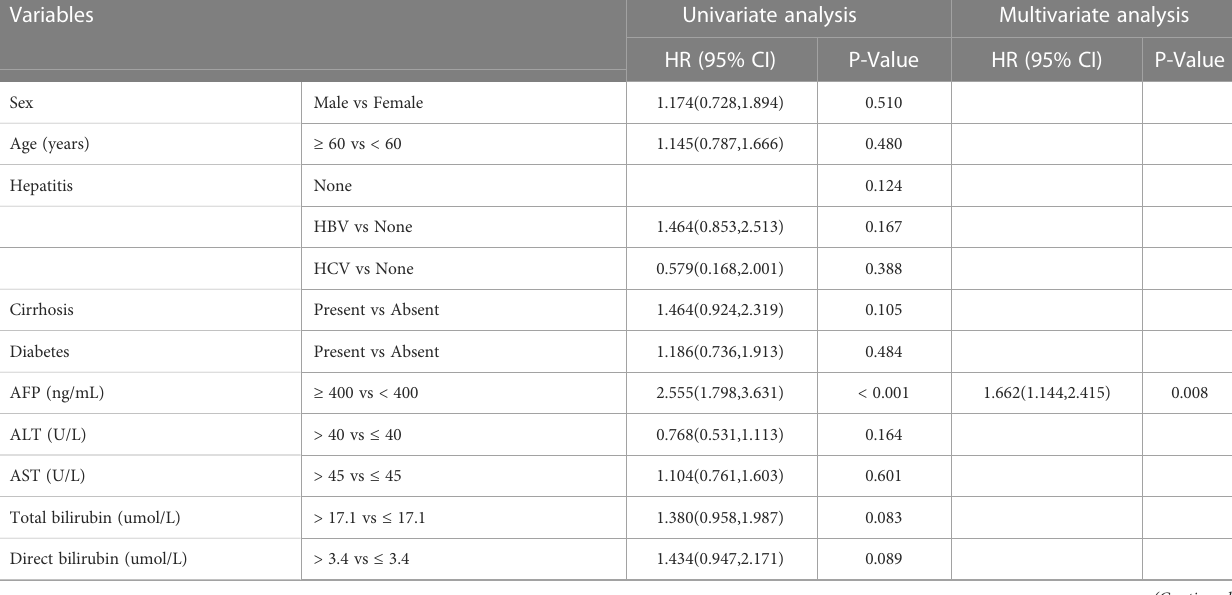
TABLE 2 Cox proportional hazards regression analysis of risk factors for early recurrence in the training cohort.